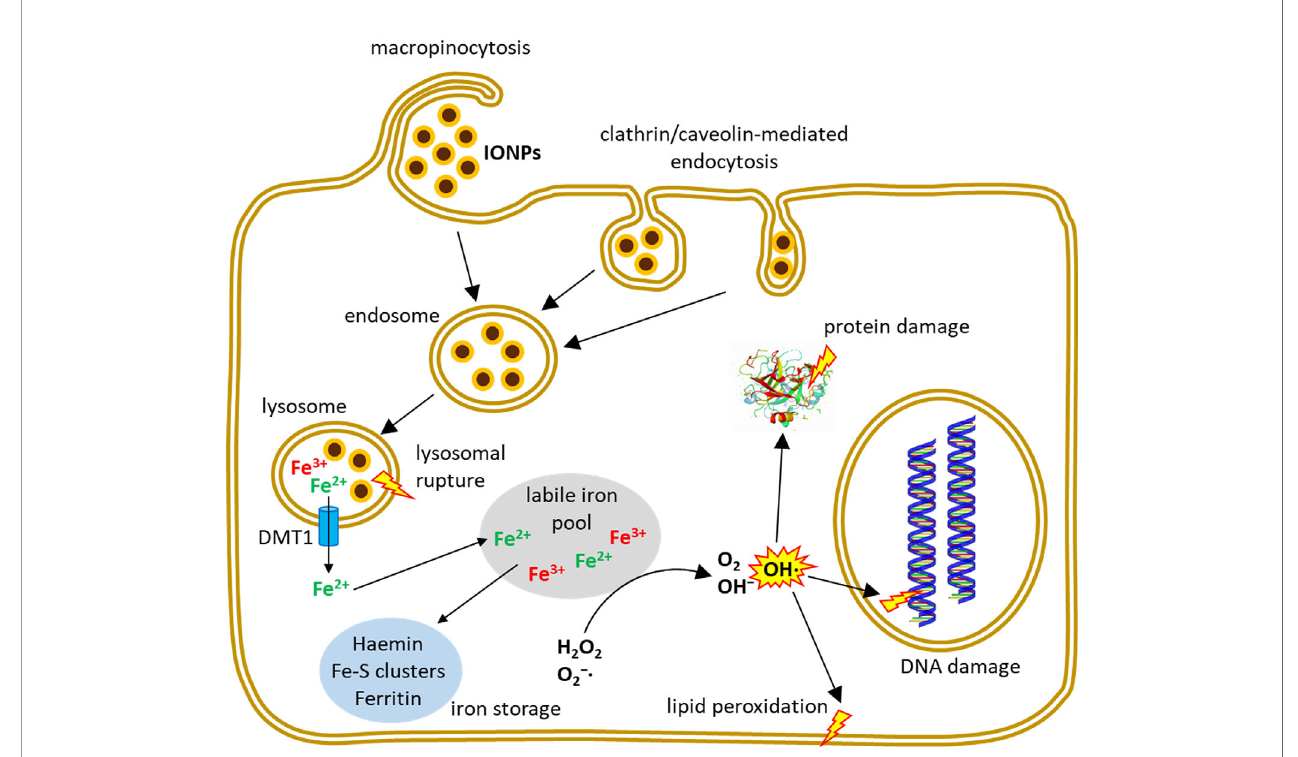
FIGURE 1 | Uptake and intracellular fate of IONPs. Depending on IONP-size and coating and on the investigated cell type, different endocytic mechanisms contribute to the uptake of intact IONPs into the cells where the particles typically enter the endo-lysosomal system. Inside the cell, iron can be liberated from the NPs and contribute to several reactions including Fenton- and Haber-Weiss reactions leading to the formation of hydroxyl radicals which can induce cell